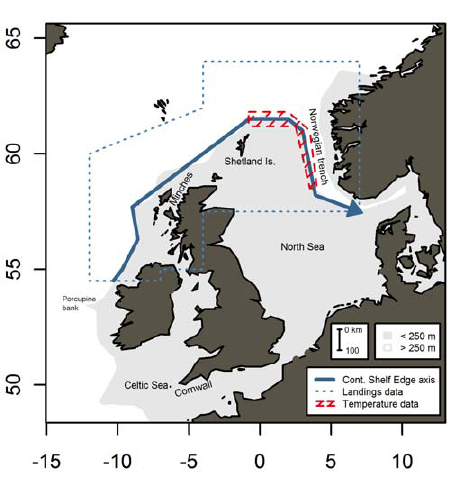
Figure 1. Map of study area and place names referred in the text. Continental shelf marked in grey (bottom depth , 250 m). Blue polygon indicates the study area. Blue bold arrow shows the Continental shelf edge axis. Red shaded area marks the area of temperature profiles.